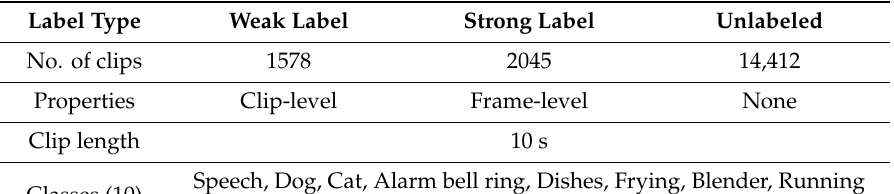
Table 1. Training data.